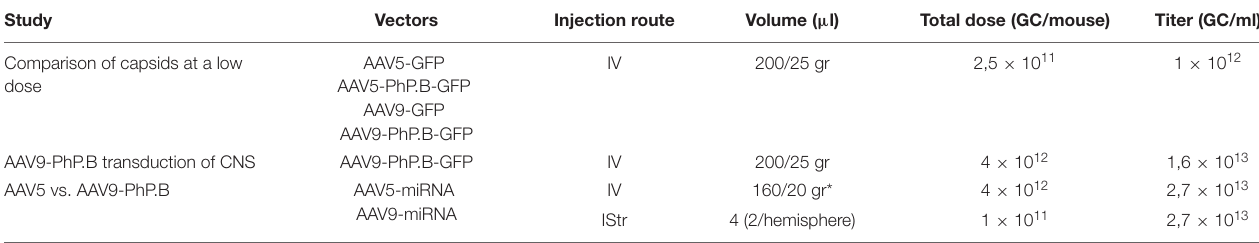
TABLE 1 | Overview of injection routes, vectors, and dosage used. Study Vectors Injection route Comparison of capsids at a low